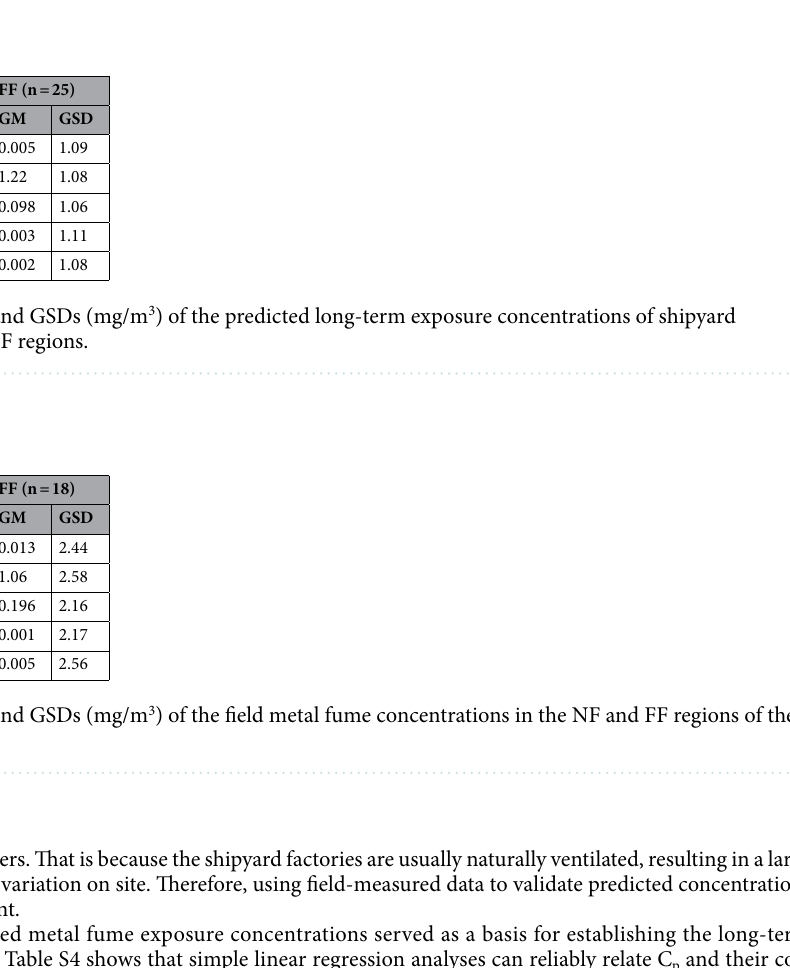
Table 2. The measured NF and FF metal concentrations (C m ) obtained from the welding simulations for two welding processes (mg/m 3 ).